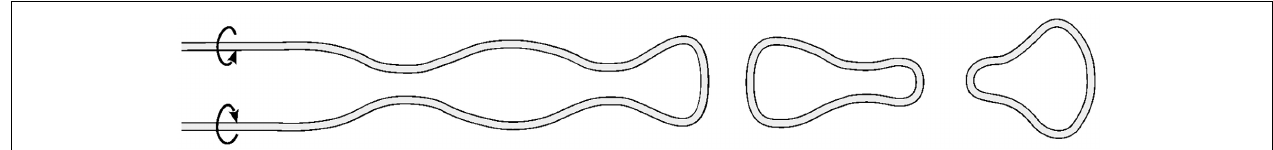
FIGURE 1 | Sketch of the Crow instability in which anti-parallel vortex filaments develop into vortex rings through the reconnection process.